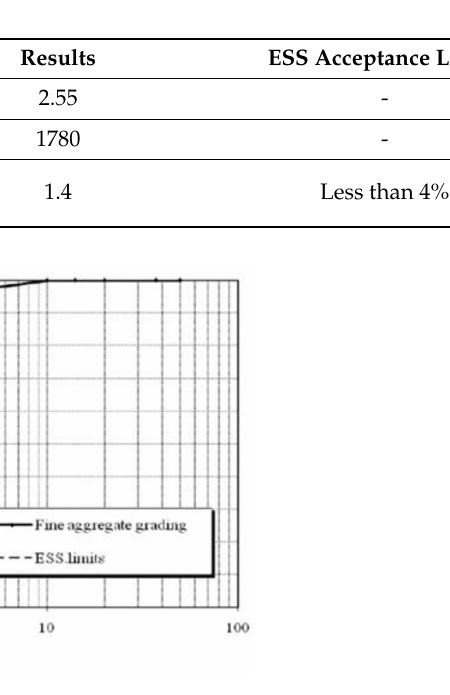
Figure 1. Fine aggregate grading curve.